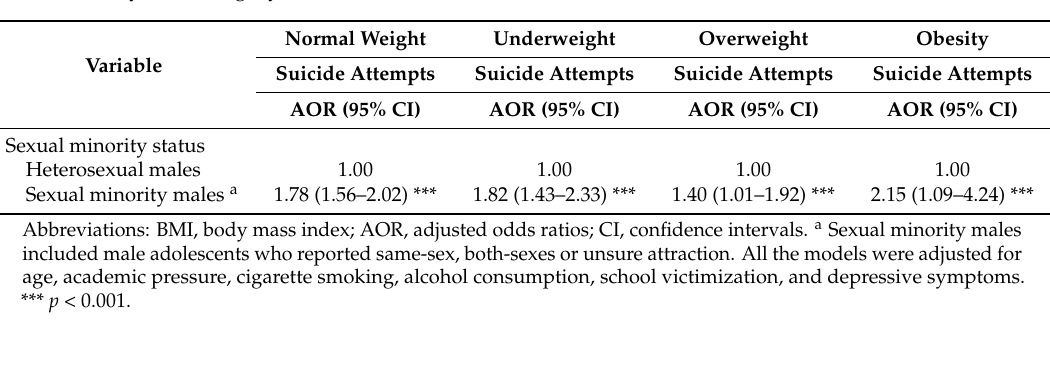
Table 3. Association between sexual minority status and suicide attempts among male adolescents, stratified by BMI category (N =